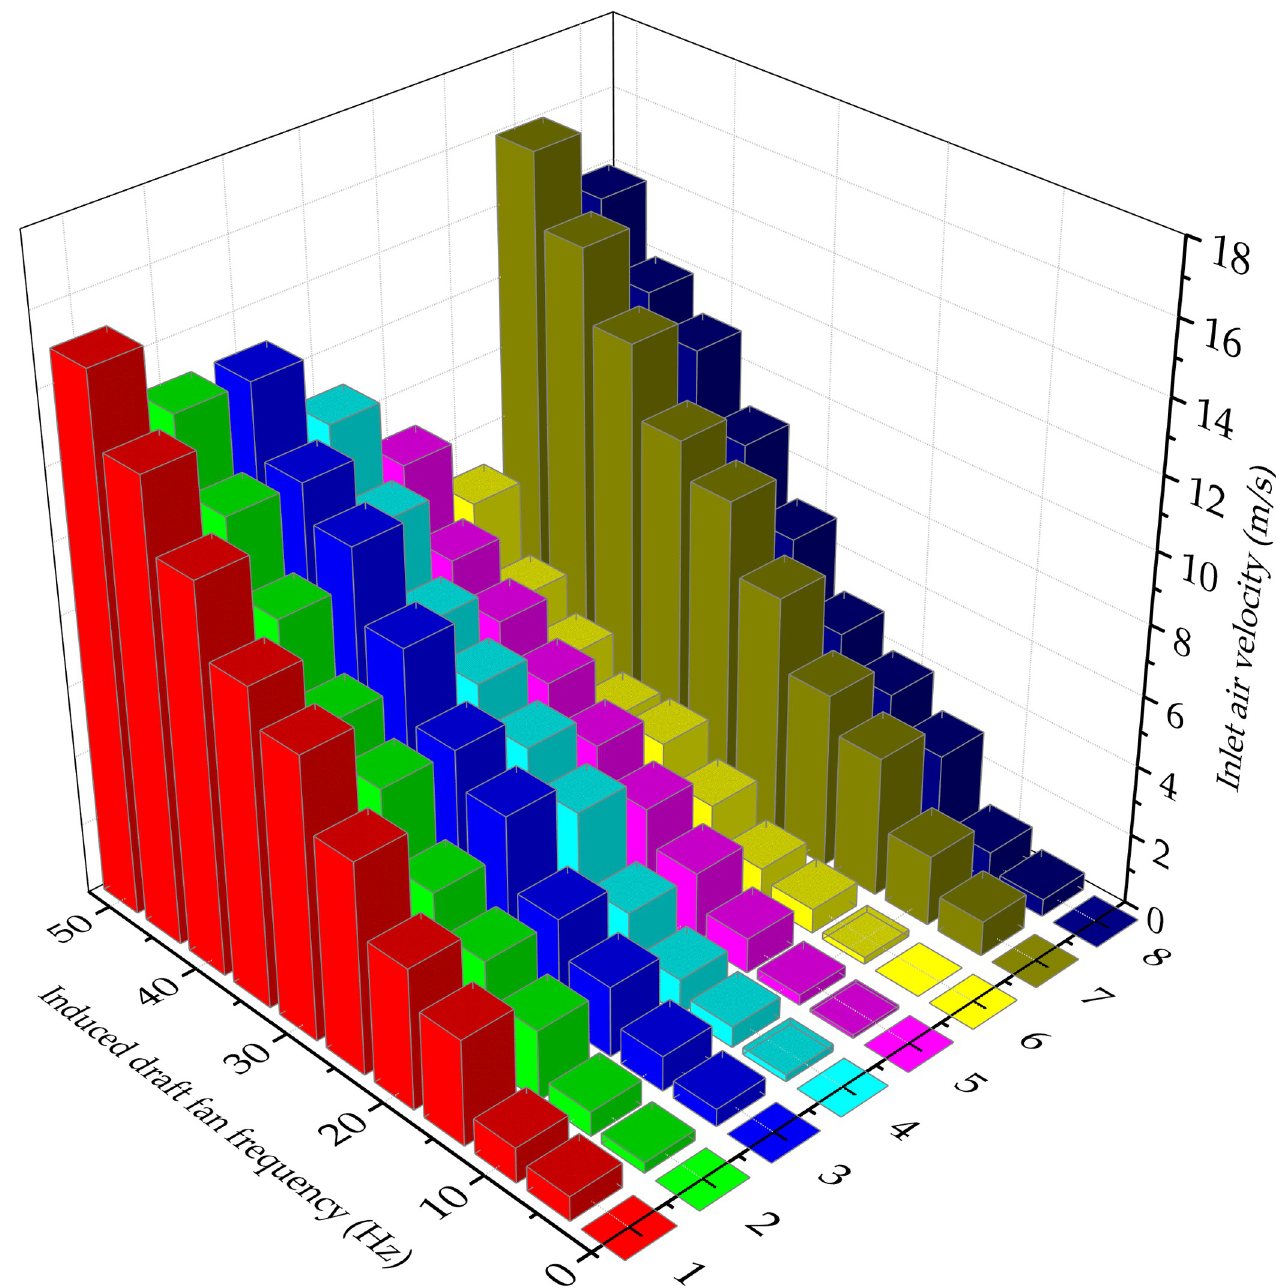
Fig 10. Air velocity value corresponding to different frequency of the dryer. (1) Straight pipe airflow velocity of 10 wt% wood fibers, (2) Impulse pipe airflow velocity of 10 wt% wood fibers, (3) Straight pipe airflow velocity of 30 wt% wood fibers, (4) Impulse pipe airflow velocity of 30 wt% wood fibers, (5) Straight pipe airflow velocity of 50 wt% wood fibers, (6) Impulse pipe airflow velocity of 50 wt% wood fibers, (7) No-load straight pipe airflow velocity, (8) No-load impulse pipe airflow